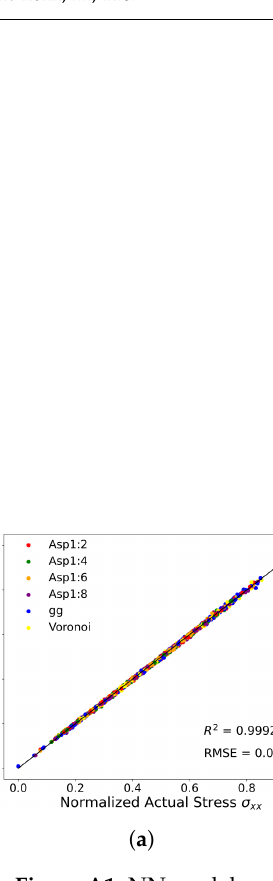
Figure A1. NN model prediction of normal stress σ xx for ( a ) training data ( b ) validation data ( c ) test data. The solid line represents the line of ideality. Asp1:2, Asp1:4, Asp1:6, Asp1:8 and gg represents columnar grain structure of aspect ratio 1:2,1:4,1:6,1:8 and grain growth structure, respectively.